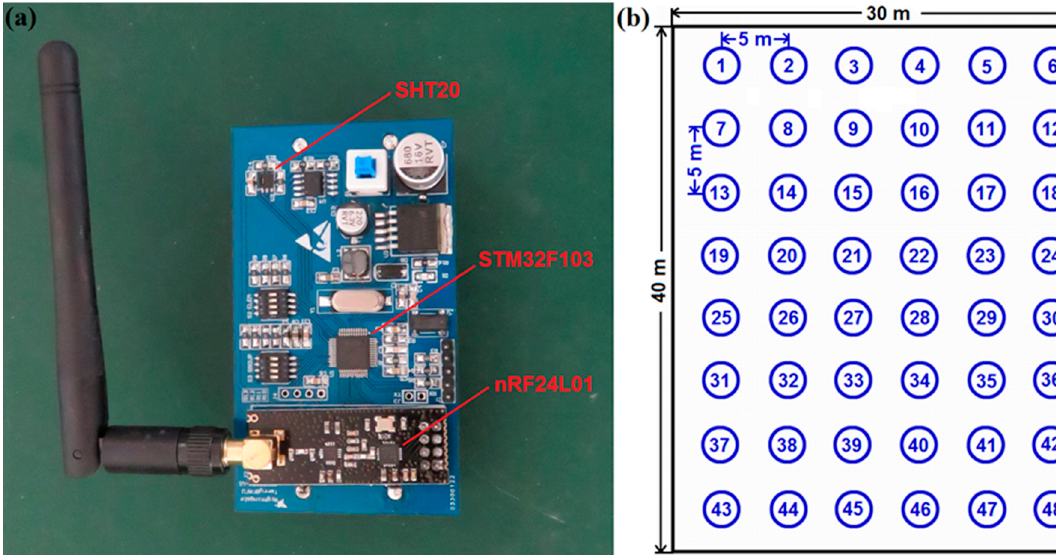
Figure 7. ( a ) Illustration of the wireless sensor node for experiments; ( b ) Illustration of the deployment of sensor nodes for experiments.